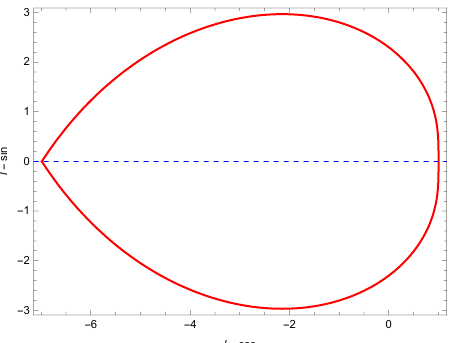
Figure 1. Polar plot of the fundamental l-trigonometric